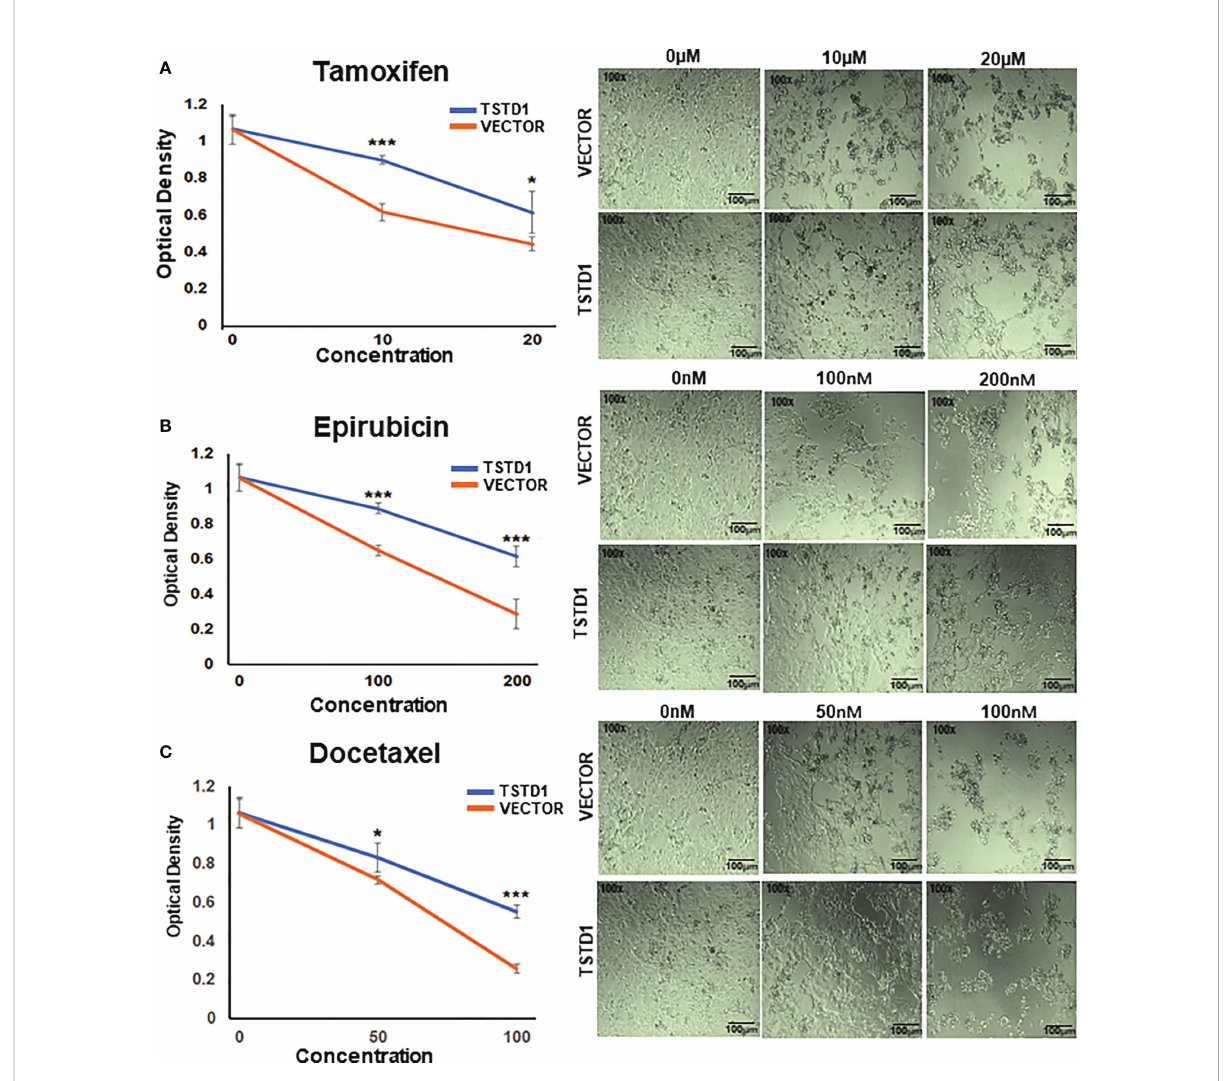
FIGURE 5 TSTD1 overexpression mediated poor treatment response. Cell proliferation assays were performed in MCF7 cells treated with (A) Tamoxifen, (B) Epirubicin, and (C) Docetaxel after TSTD1 plasmid transfection, in a dose-dependent manner. The result was analyzed using students paired t-test. The data are presented as the means ± SD. *p ≤ 0.05, **p ≤ 0.01, ***p ≤ 0.001